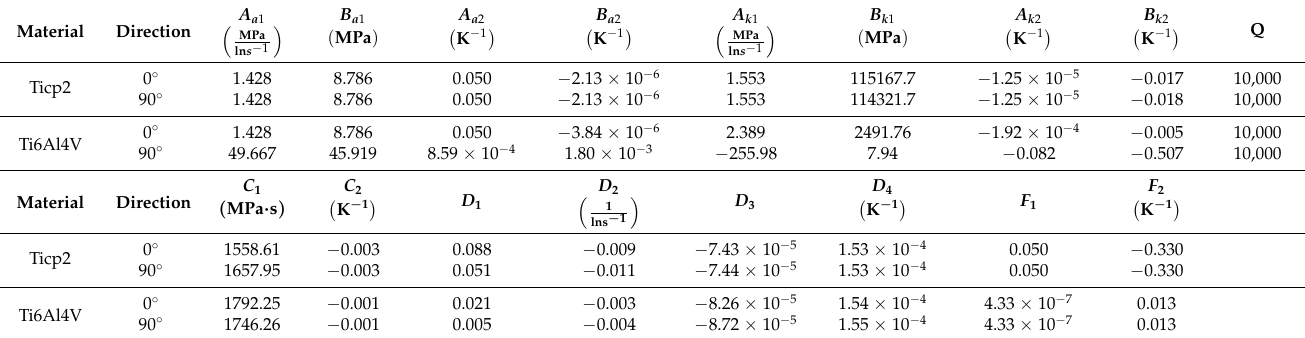
Table 2. Material parameters of the asymmetric constitutive model for Ticp2 and Ti6Al4V. Material